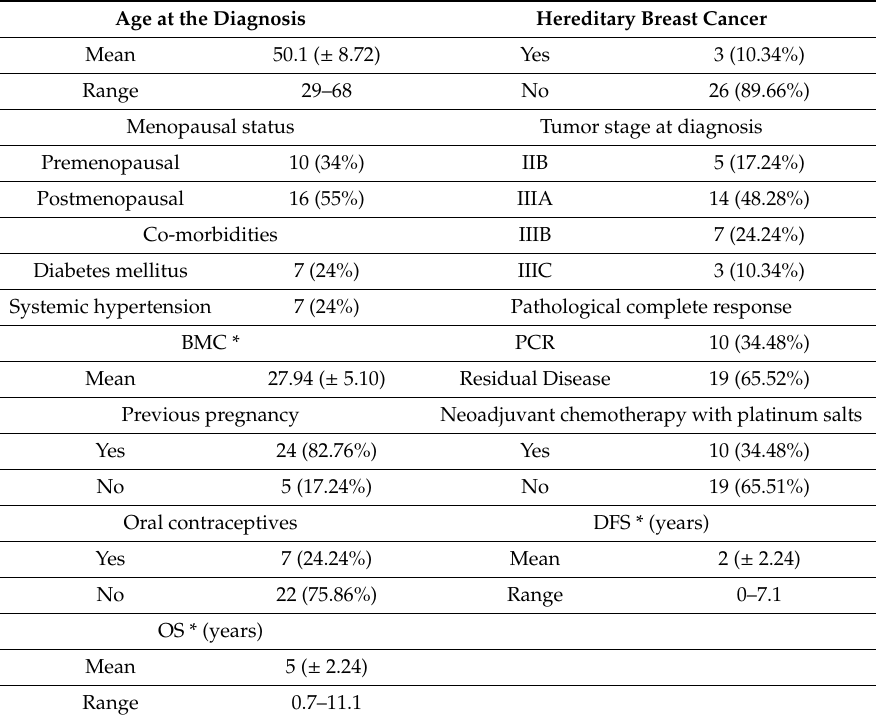
19 / 29) and (2) conventional chemotherapy plus platinum salt derivatives, 34% (10 / 29; Ch-PLA). Table 1. Clinical characteristics of the patients ( n =